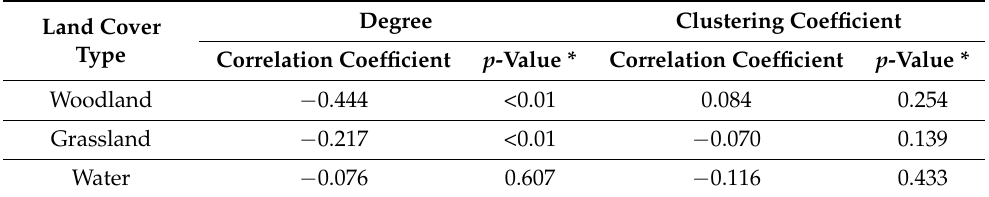
Table 3. Correlation analysis between NPP and topological indices of different land cover types.